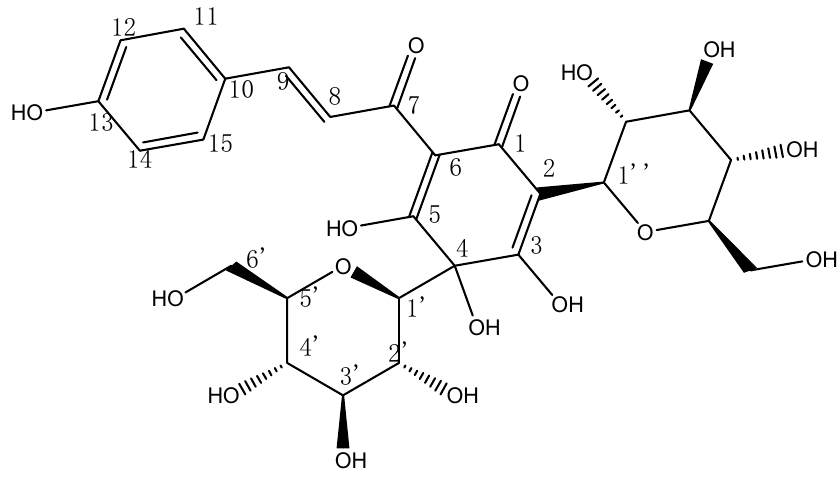
Figure 1. The chemical structure of